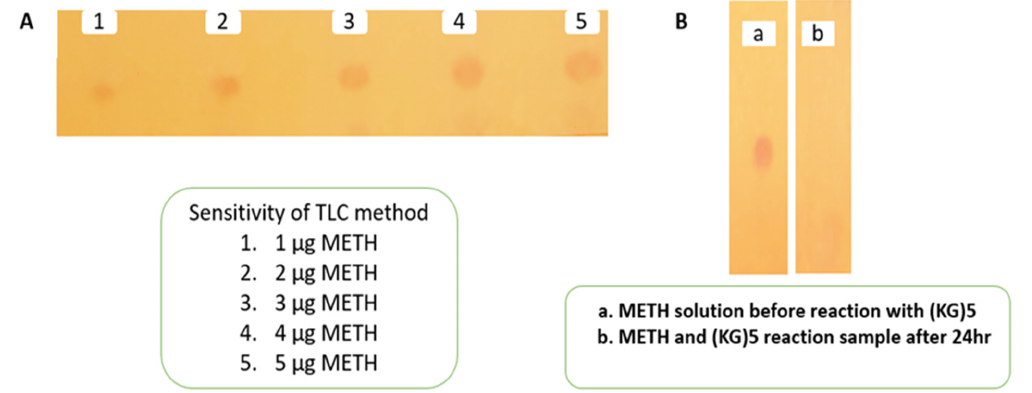
Figure 2. Monitoring of reaction completion between METH and (KG) 5 by TLC. ( A ) Sensitivity of TLC method, ( B ) confirmation of reaction between METH and (KG) 5 .